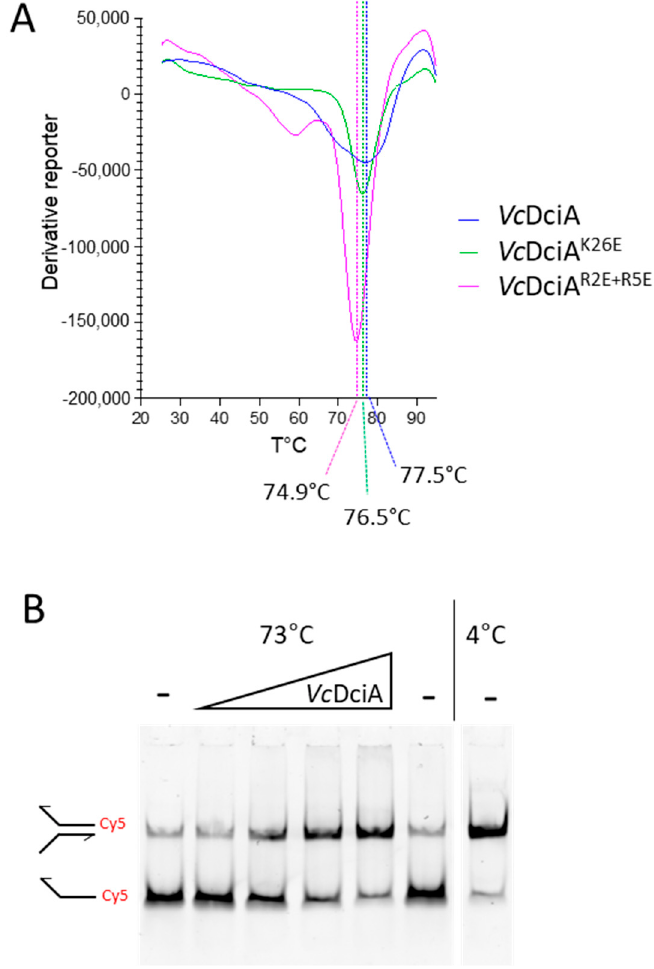
Figure 3. Vc DciA interacts with a fork-like DNA and protects it from thermal denaturation. ( A ) Thermal Shift Assays on Vc DciA, Vc DciA R2E+R5E , and Vc DciA K26E : first-order derivatives generated as a function of temperatures are presented. One curve of three independent experiments is presented for each protein. ( B ) The oligonucleotides forming the fork-like DNA subtract were hybridized on 25 nucleotides over 50 (nt), mimicking a replication fork (oso3 and oso4, Table 1). One of the two strands is labeled 3 ′ with a Cy5 fluorophore. A range of protein concentrations (0.25; 0.5; 0.75; 1 µM) was mixed with the fork-like DNA substrate and placed at 73 °C for 30 min. The DNA molecules were visualized by migration on a 6% native acrylamide gel and revealed by chemiluminescence. The controls of the forked DNA incubated at 4 °C or 73 °C without Vc DciA were placed on either side of the gel.